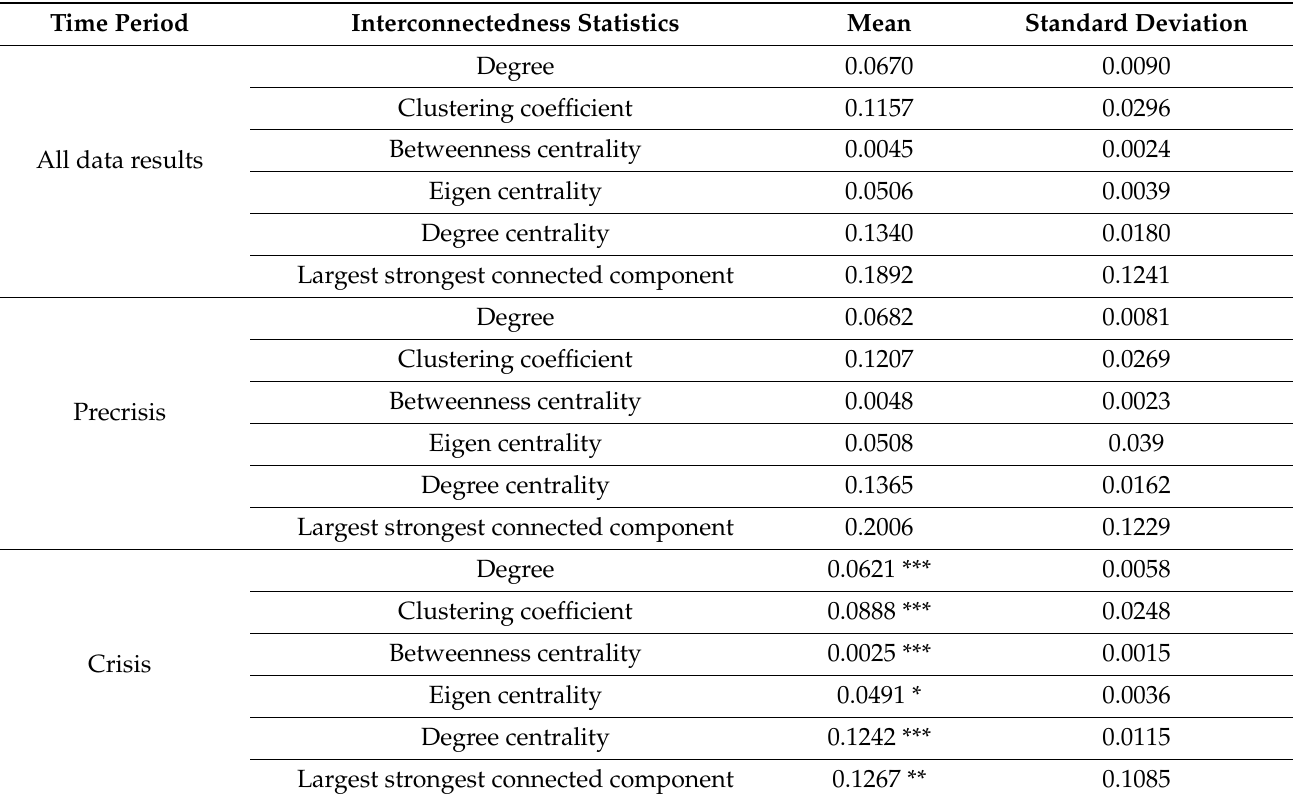
Table 2. Summary statistics of weekly aggregated e-MID interbank network in top 100 Italian banks. The average degree in each network is referred to as Degree. The clustering coefficient is denoted as the Clustering coefficient. The three different centrality measures are degree centrality, betweenness centrality and Eigen centrality. Additionally, the fraction of nodes in the largest strongly connected component is the largest strongest connected component. The significance levels of 10% (*), 5% (**) and 1% (***) are used to assess the mean difference between the crisis and the precrisis period with the t